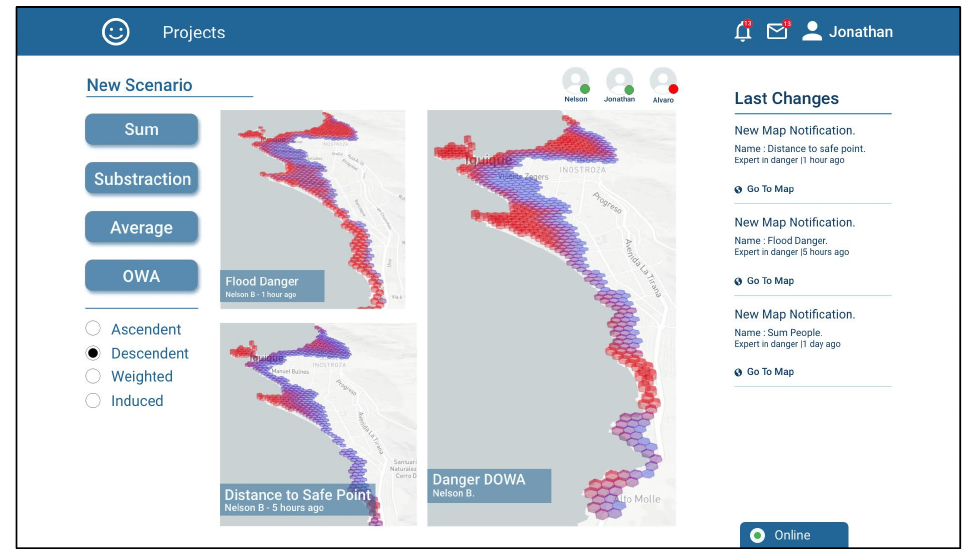
Figure 8. Screenshot showing Jonathan combining the two maps generated by him using the OWA-DESC operator.